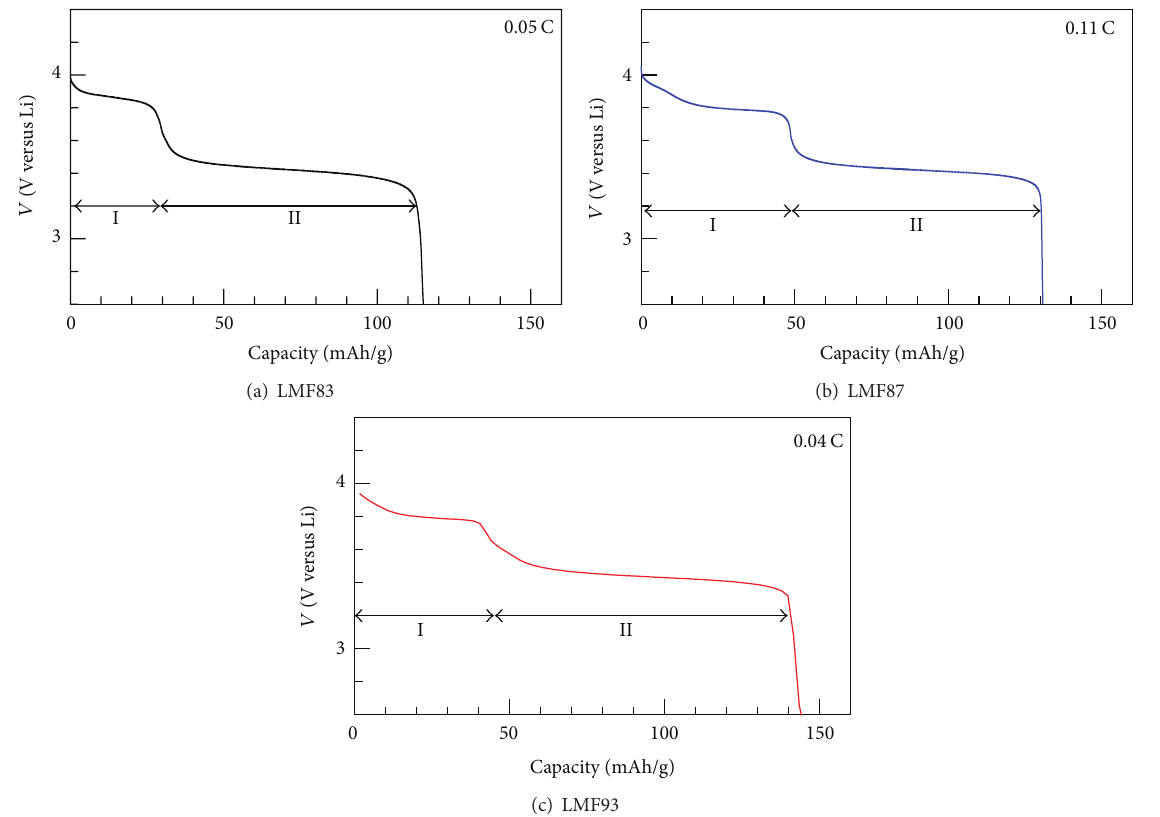
Figure 6: OCV discharge curves of (a) LMF83, (b) LMF87, and (c) LMF93 films against Li. For convenience of explanation, we define plateaus I and II (cited from [18]).